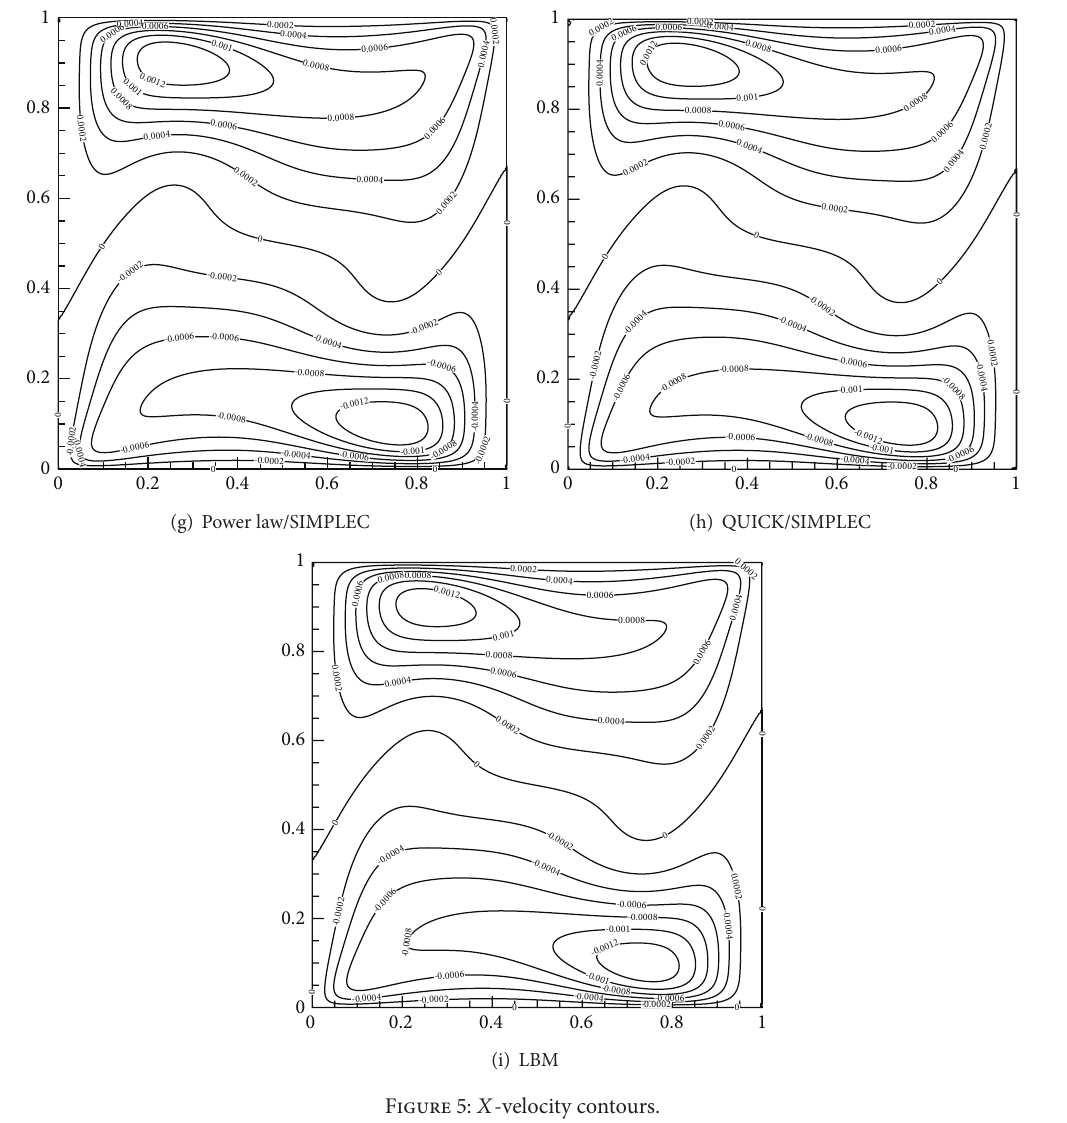
Figure 5: 𝑋 -velocity contours.